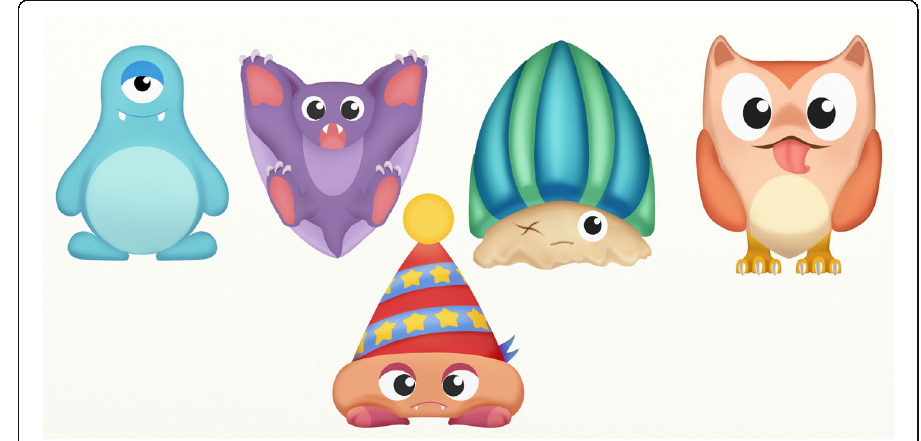
Fig. 2 The TrueBiters monsters representing the logical